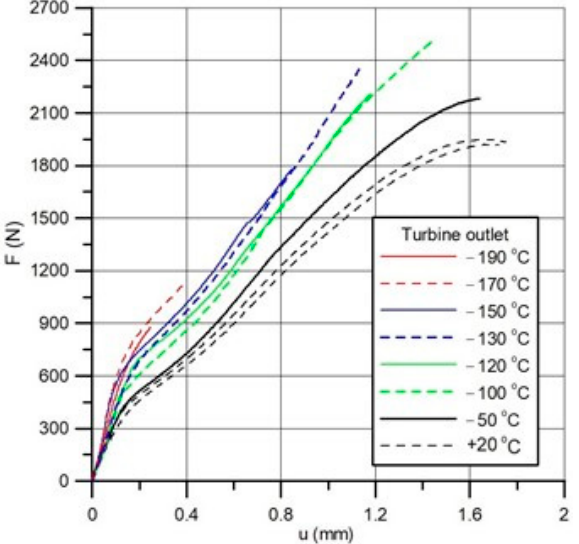
Figure 6. Testing in ambient and low temperatures–SPT curves obtained for outlet part specimens (F, force; u, displacement).